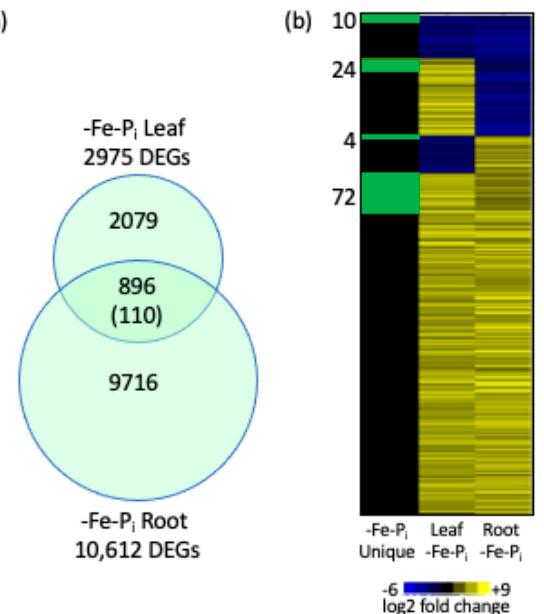
Figure 5. Gene expression conserved between tissues. There are 896 genes differentially expressed in both leaves and roots under -Fe-P i growth conditions, with 110 genes unique to -Fe-P i ( a ). Heatmap (using log2 expression) of the 896 DEGs common to -Fe-P i tissues ( b ) yellow indicates gene expression is upregulated while blue indicates gene expression is downregulated compared to control samples. The distribution of the 110 genes unique to -Fe-P i conditions is highlighted in green to the left of the heatmap and in column labeled -Fe-P i unique.